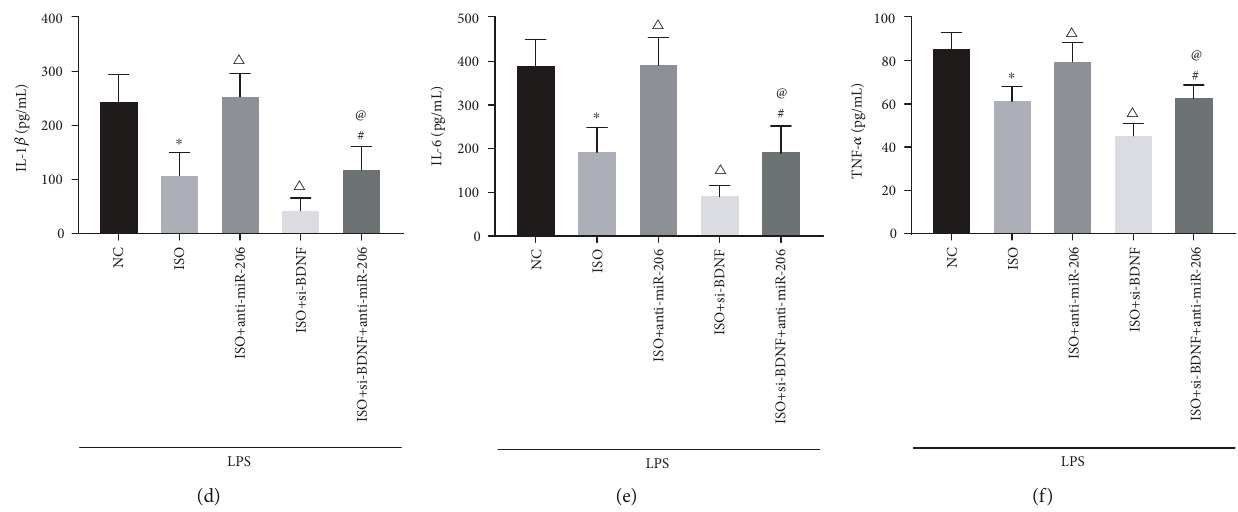
Figure 4: ISO regulated the e ff ects of miR-206/BDNF axis on LPS-induced NHA cell proliferation, apoptosis, and in fl ammatory response. (a) Western blotting was applied to measure the expression of BDNF. (b) The proliferation activity of NHAs cells was detected by MTT. (c) Annexin V-FITC/PI was used to detect NHA cell apoptosis. (d – f) Expression of IL-6, IL-1 β , and TNF- α in NHAs cells was detected by ELISA. ∗ p < 0 : 05 vs. the NC group; Δ p < 0 : 05 vs. the ISO group; # p < 0 : 05 vs. the ISO+anti-miR-206 ; @ p < 0 : 05 vs. the ISO+si-BDNF